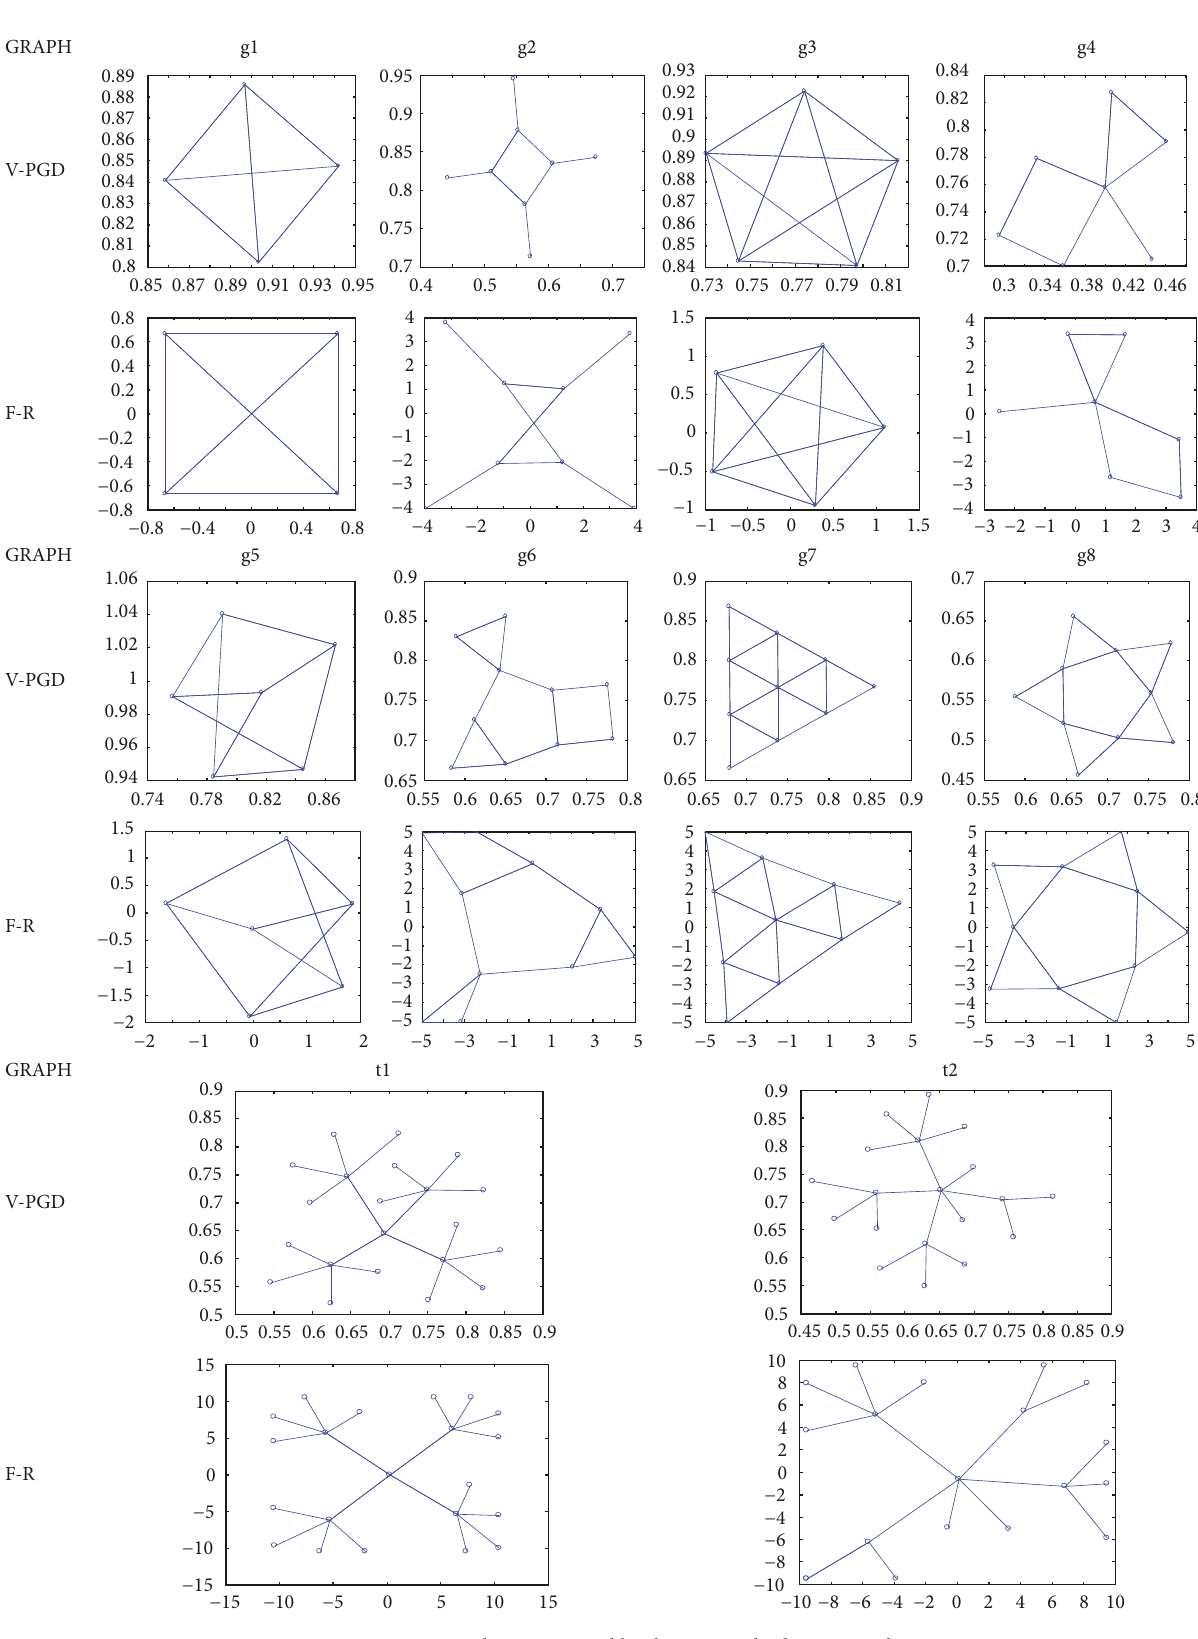
Figure 3: Drawings by V-PGD and by the F-R method on 10